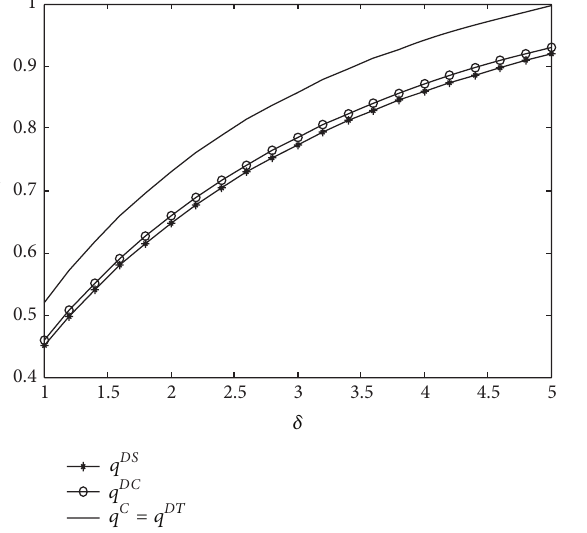
Figure 5: Impact of 𝛿 on optimal promotion level.